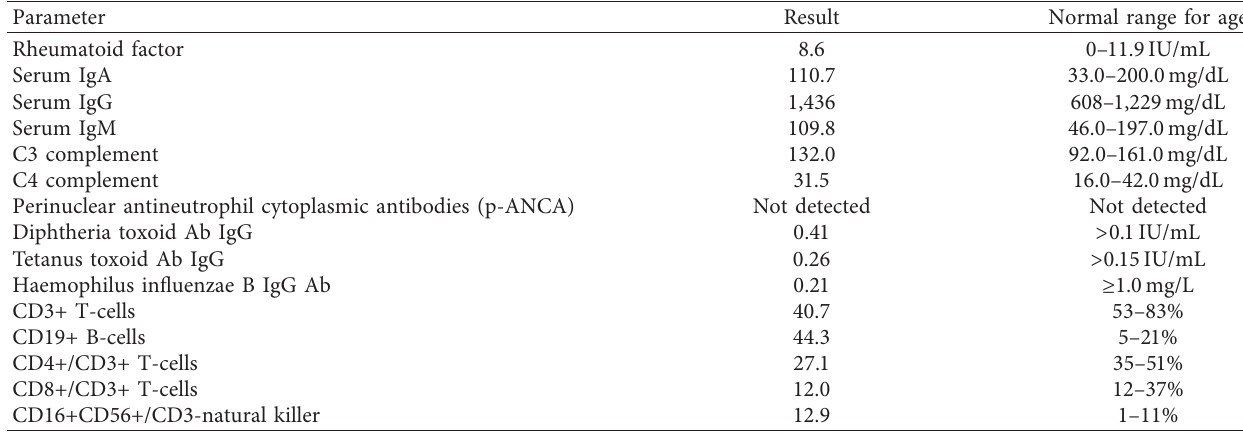
Table 2: Pertinent rheumatological and immunological laboratory results of our patient.